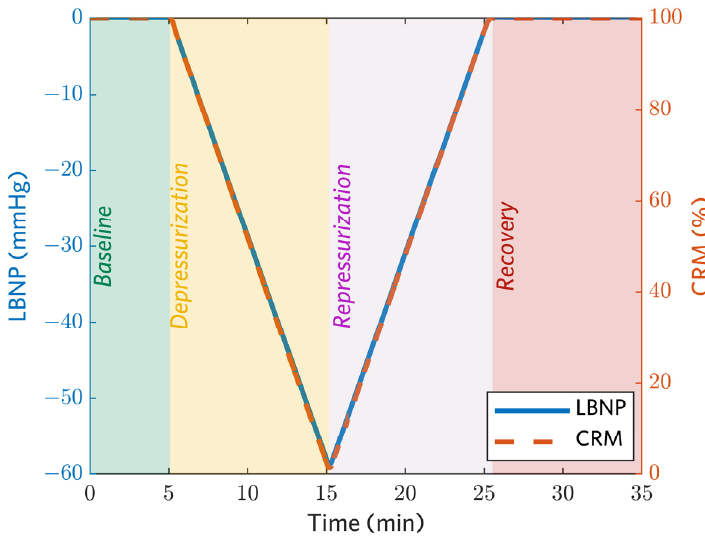
Figure 1. Representative negative pressure application protocol and reference CRM (RCRM) values during the baseline, depressurization, repressurization, and recovery phases of the LBNP studies. The duration of each phase varied based on the ramp speed selected for that trial.